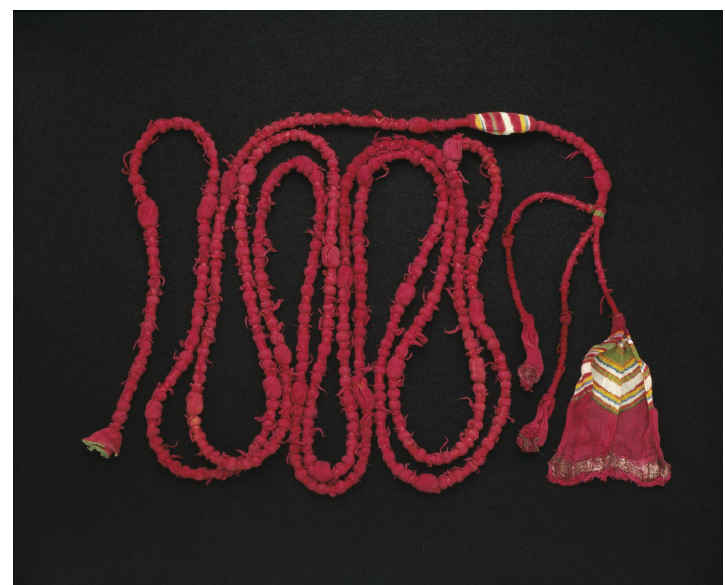
Figure 5 Figure 5. Sample of tie-dyed cloth, tie-dyed cotton, wrap-resist ( lahariy¯a ), Jaipur, c. 1950s. Given by Mrs. M. Hamill, IS.63-1959. © Victoria and Albert Museum, London.